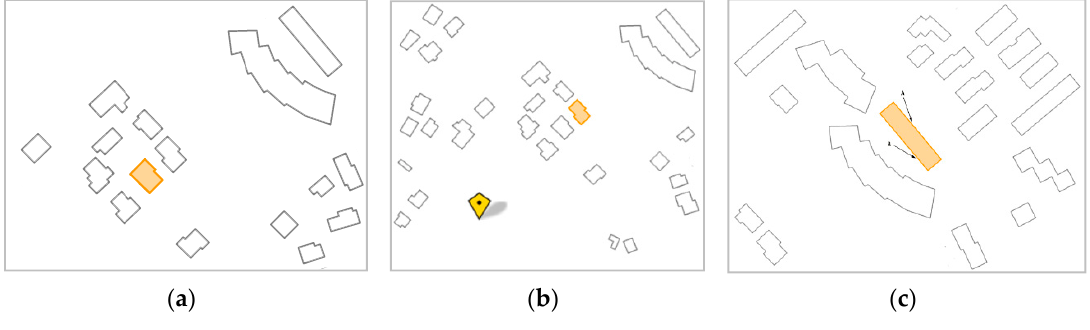
Figure 19 . Test for the geographic ( a ), deictic ( b ), and geometric ( c ) frame of reference.